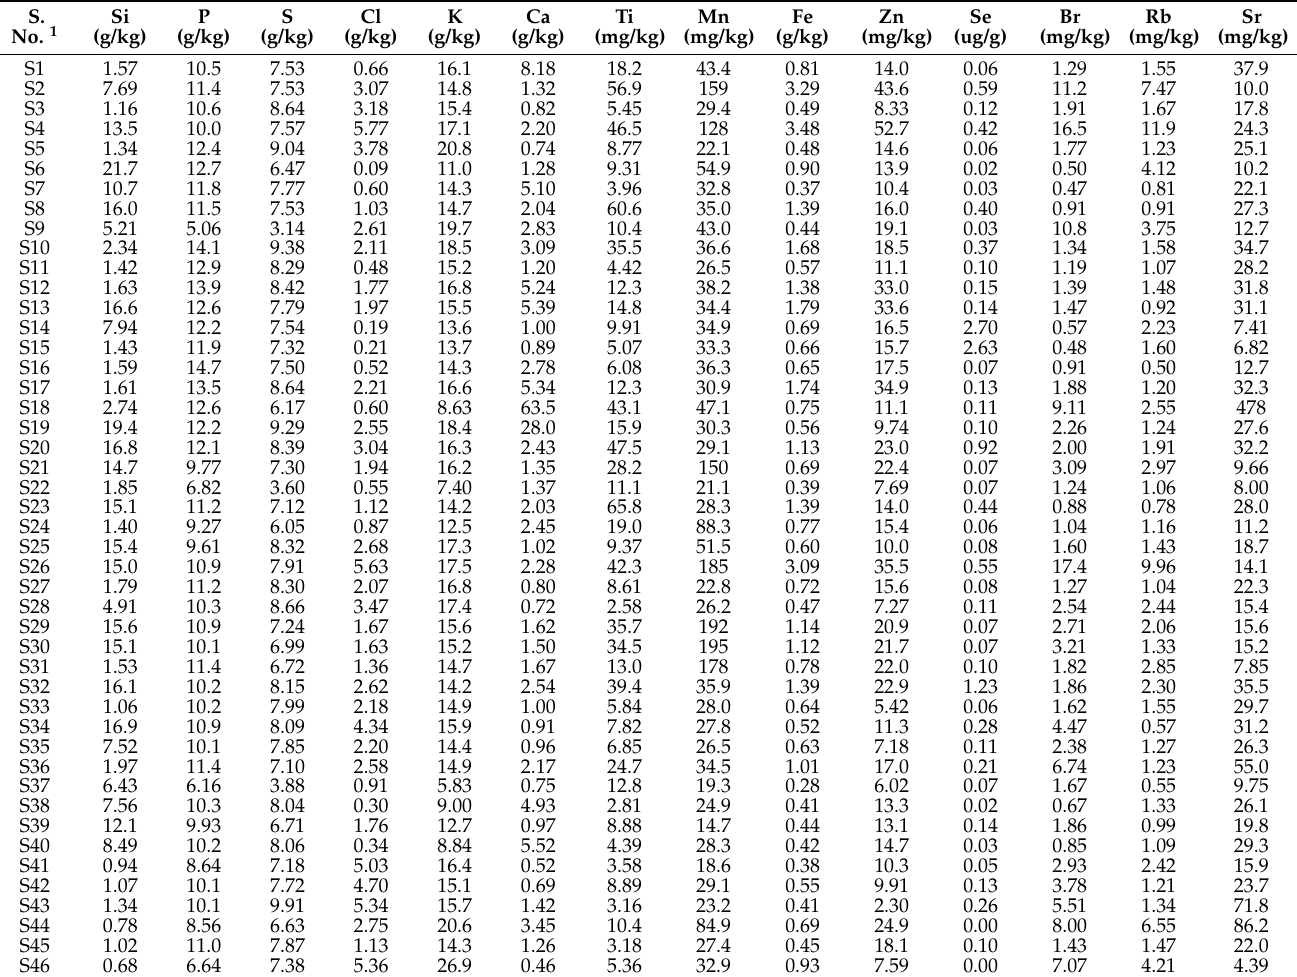
Table 2. Macro-element composition of Spirulina supplements available on the Slovenian